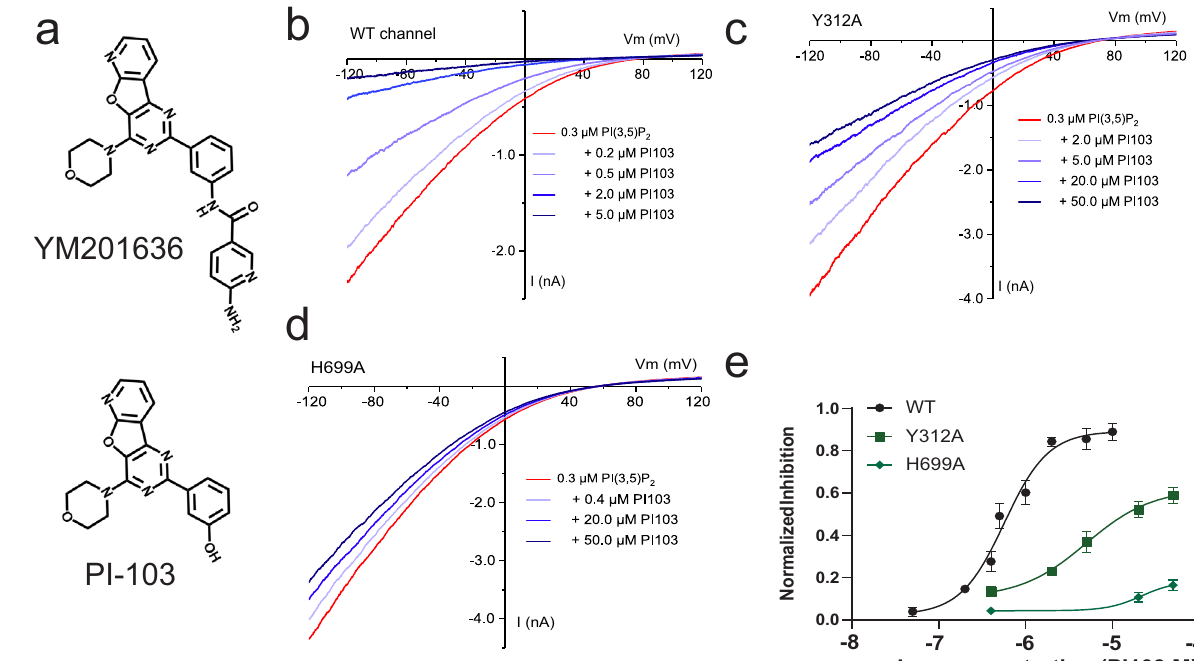
Fig. 6 Inhibition of the human TPC2 channel by PI-103. a The chemical structures of YM201636 and PI-103. b – d The effect of PI-103 on WT ( b ) and Y312A ( c ) and H699A ( d ) mutants of the human TPC2 PM channel. The channel was activated by 0.3 μ M PI(3,5)P 2 . e Dose-responses ( n = 5 – 7 for each data point) of the PI-103 ’ s inhibitory effect on WT and Y312A and H699A mutants of the human TPC2 channel, as shown in ( b – d ). All recordings were done in inside-out con fi guration using asymmetric Na + (outside)/K + (inside) recording solutions. The averaged data are presented as mean value ±